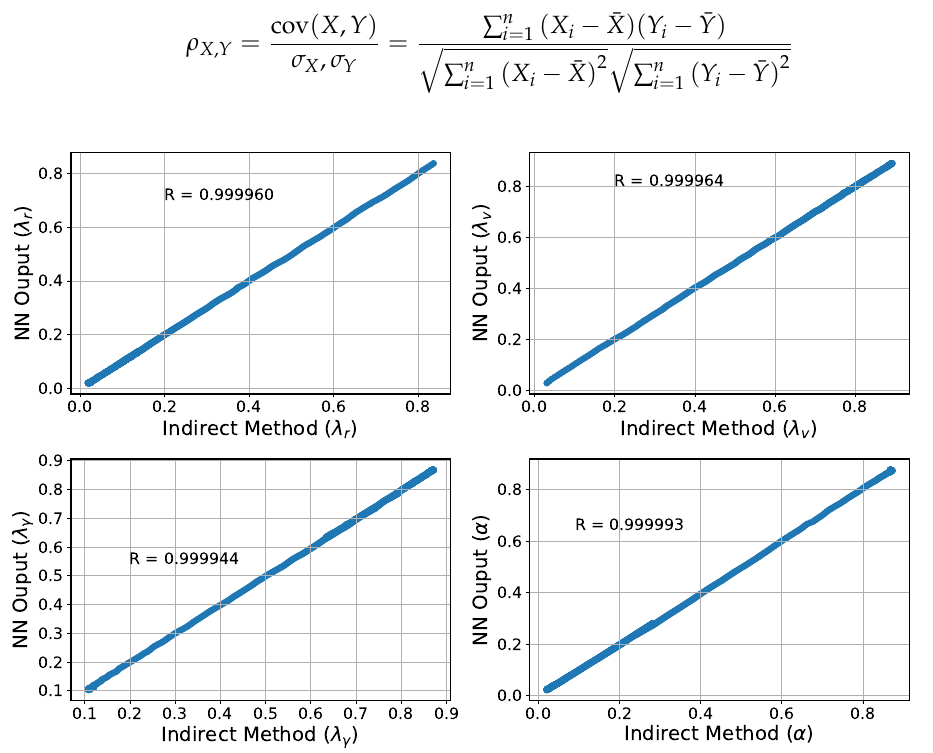
Figure 9. The regression analysis results between the predicted and the standard for